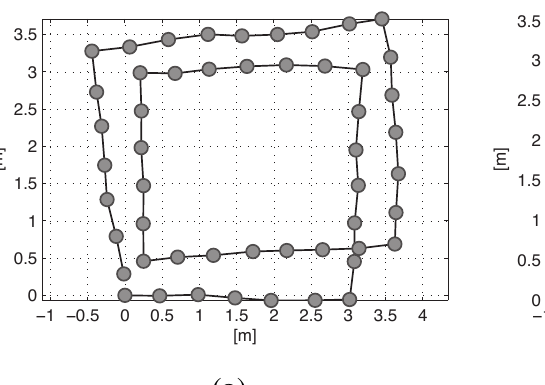
Figure 5. Full trajectory estimation; ( a ) Using only the prediction results. ( b ) Optimized using the graph SLAM